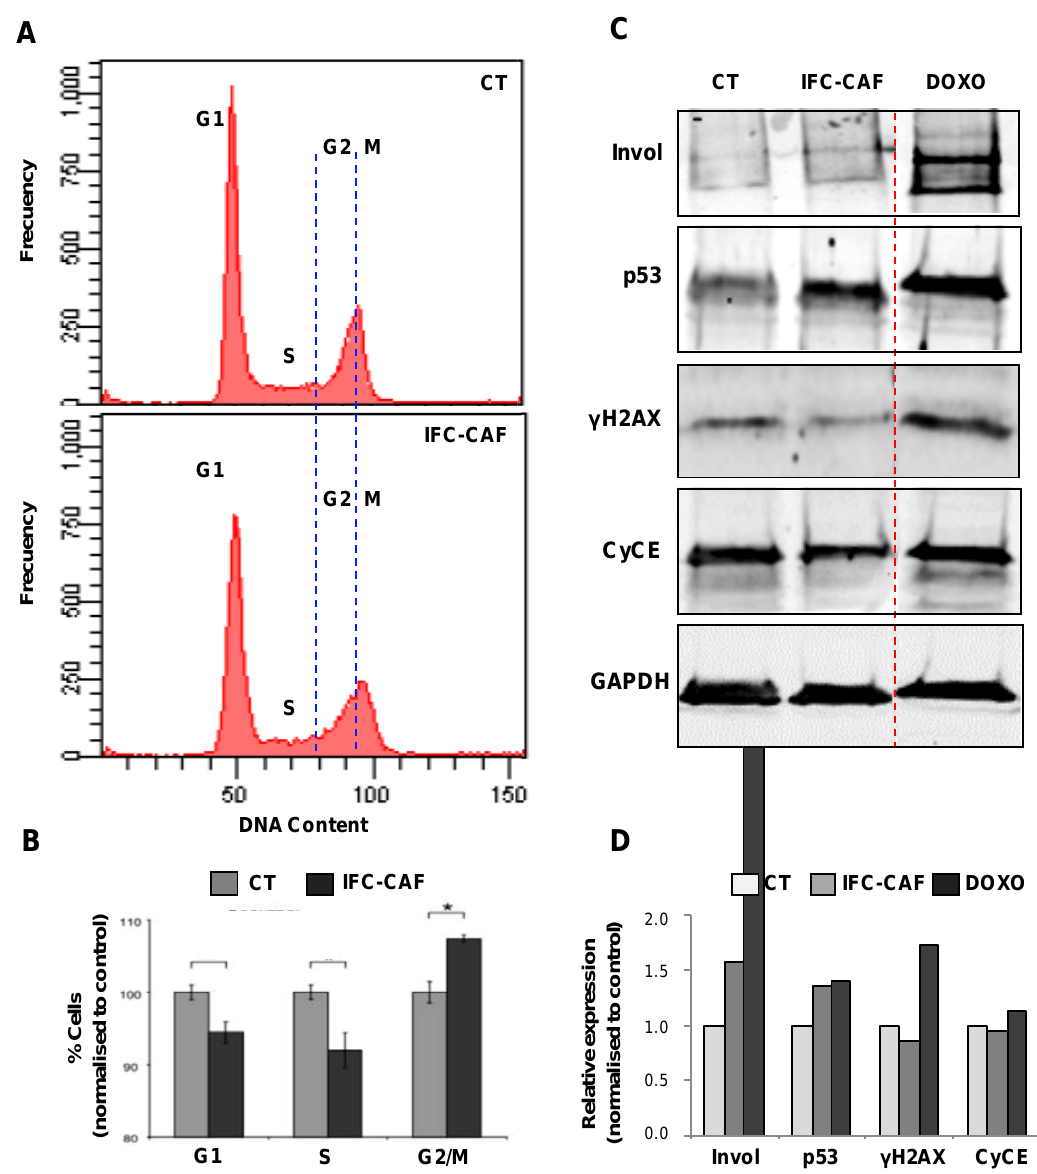
Figure 4. IFC-CAF ® slows down the progression of epidermal keratinocytes through the G2/M transition of the cell cycle and promotes the expression of p53 ( A ) Representative histogram plots of DNA content of asynchronous primary keratinocyte cultures exposed to 0,9 mg/mL for 6 days. ( B ) Quantitation of cells across cell cycle phases, untreated (CT) or 6 days after treatment with 0.9mg/mL IFC-CAF ® . Data are derived from two independent biological assays with triplicate samples. Statistical significance was assessed by Student ´ s t test (*: p < 0.05). ( C ) Western blot analyses of cell protein extracts for the indicated markers (Invol: Involucrin; CyCE: Cyclin E), for primary keratinocyte cultures either untreated (CT), exposed 6 days to 0.9mg/mL IFC-CAF ® (IFC- CAF) or treated with doxorubicin (DOXO), as indicated. ( D ) Densitometric quantification of protein bands in ( C ) as normalised to CT (invol; same number of cells loaded) or to CT and GAPDH (p53, γH2AX and CyCE; same amount of protein loaded; GAPDH as loading control).